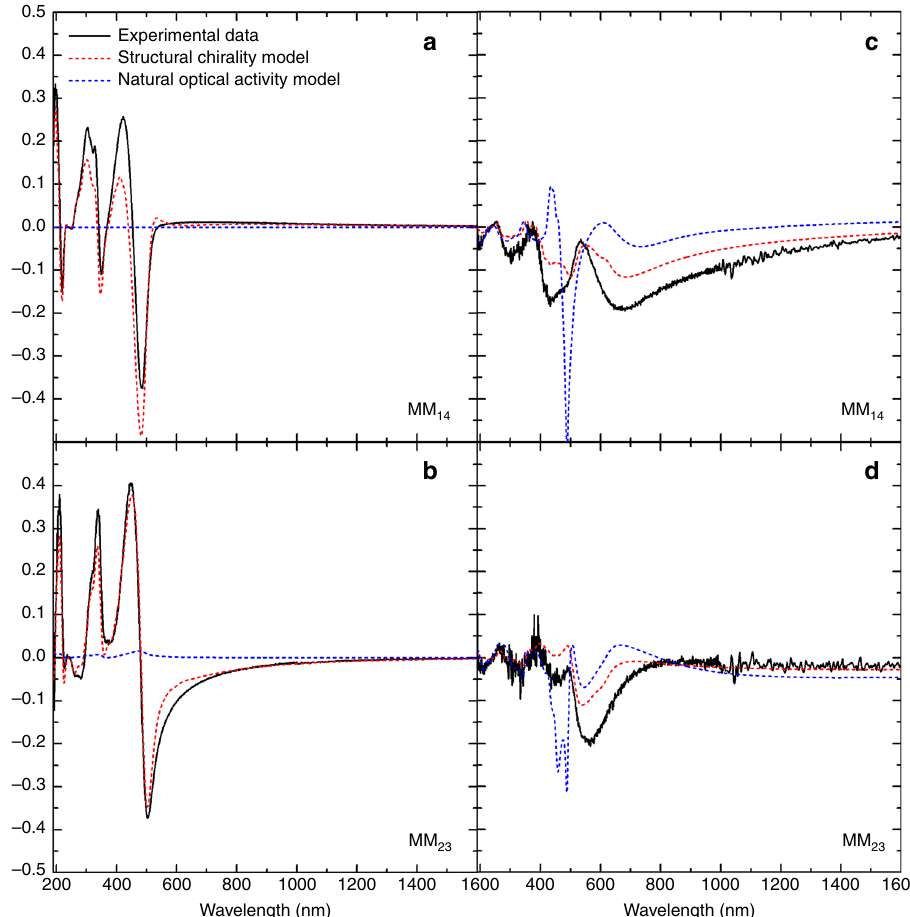
Fig. 4 Experimental and modelled MM data for aligned CSCP thin fi lms. Measured MMSE data (black solid line) associated to CD (M 14 ) and CB (M 23 ) recorded in transmission ( a , b ) and re fl ection ( c , d ) along with a model-calculated match for an aligned cPFBT fi lm assuming the origins of the chiroptical effect are structural chirality (red dashed line) or natural optical activity (blue dashed